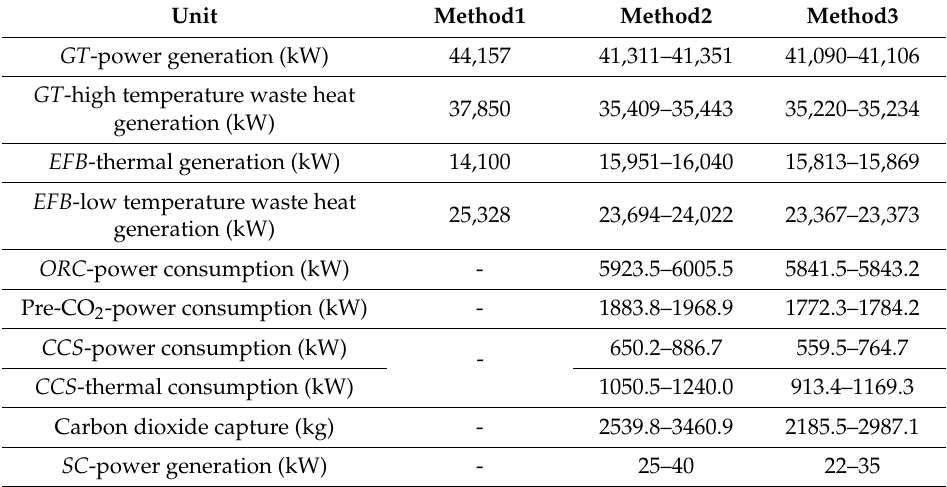
Table 3. Comparison of energy system performances using three methods at maximum reference load in 2026.